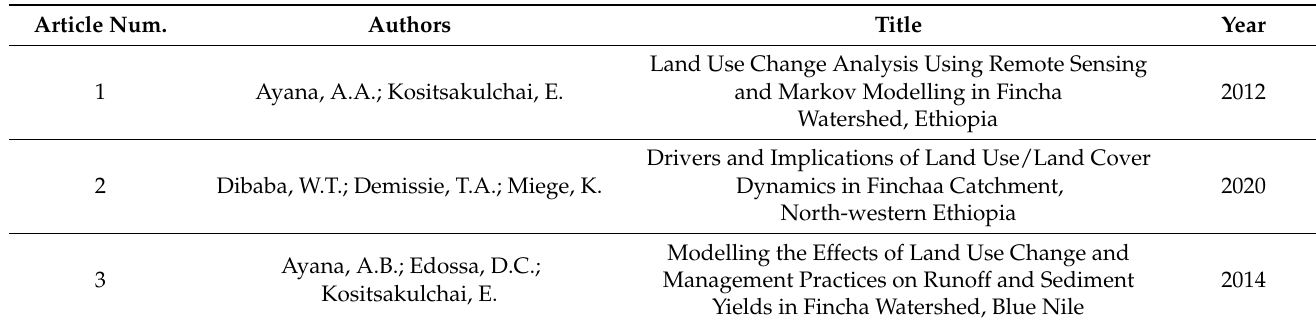
Table 1. Summary of the revised